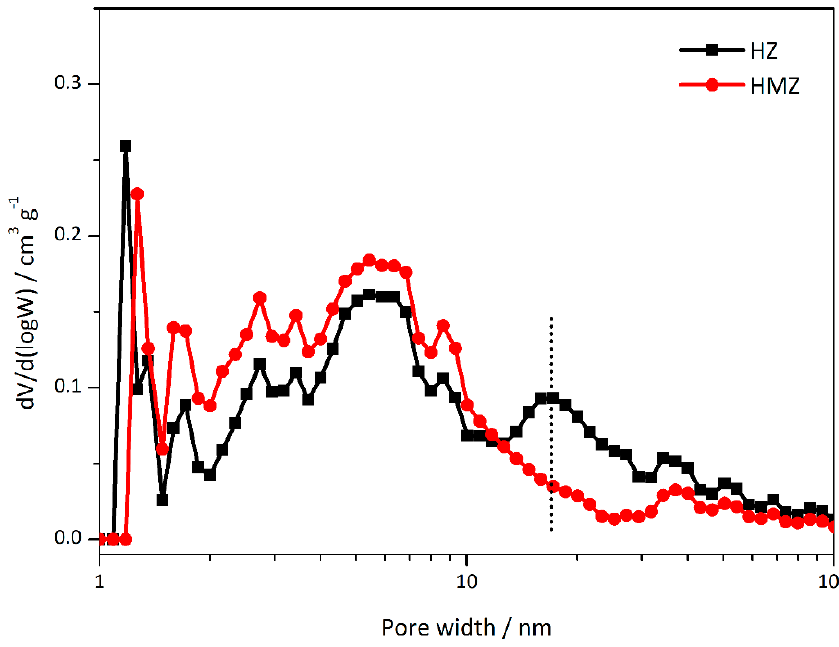
Figure 2. Pore size distribution by NLDFT method.